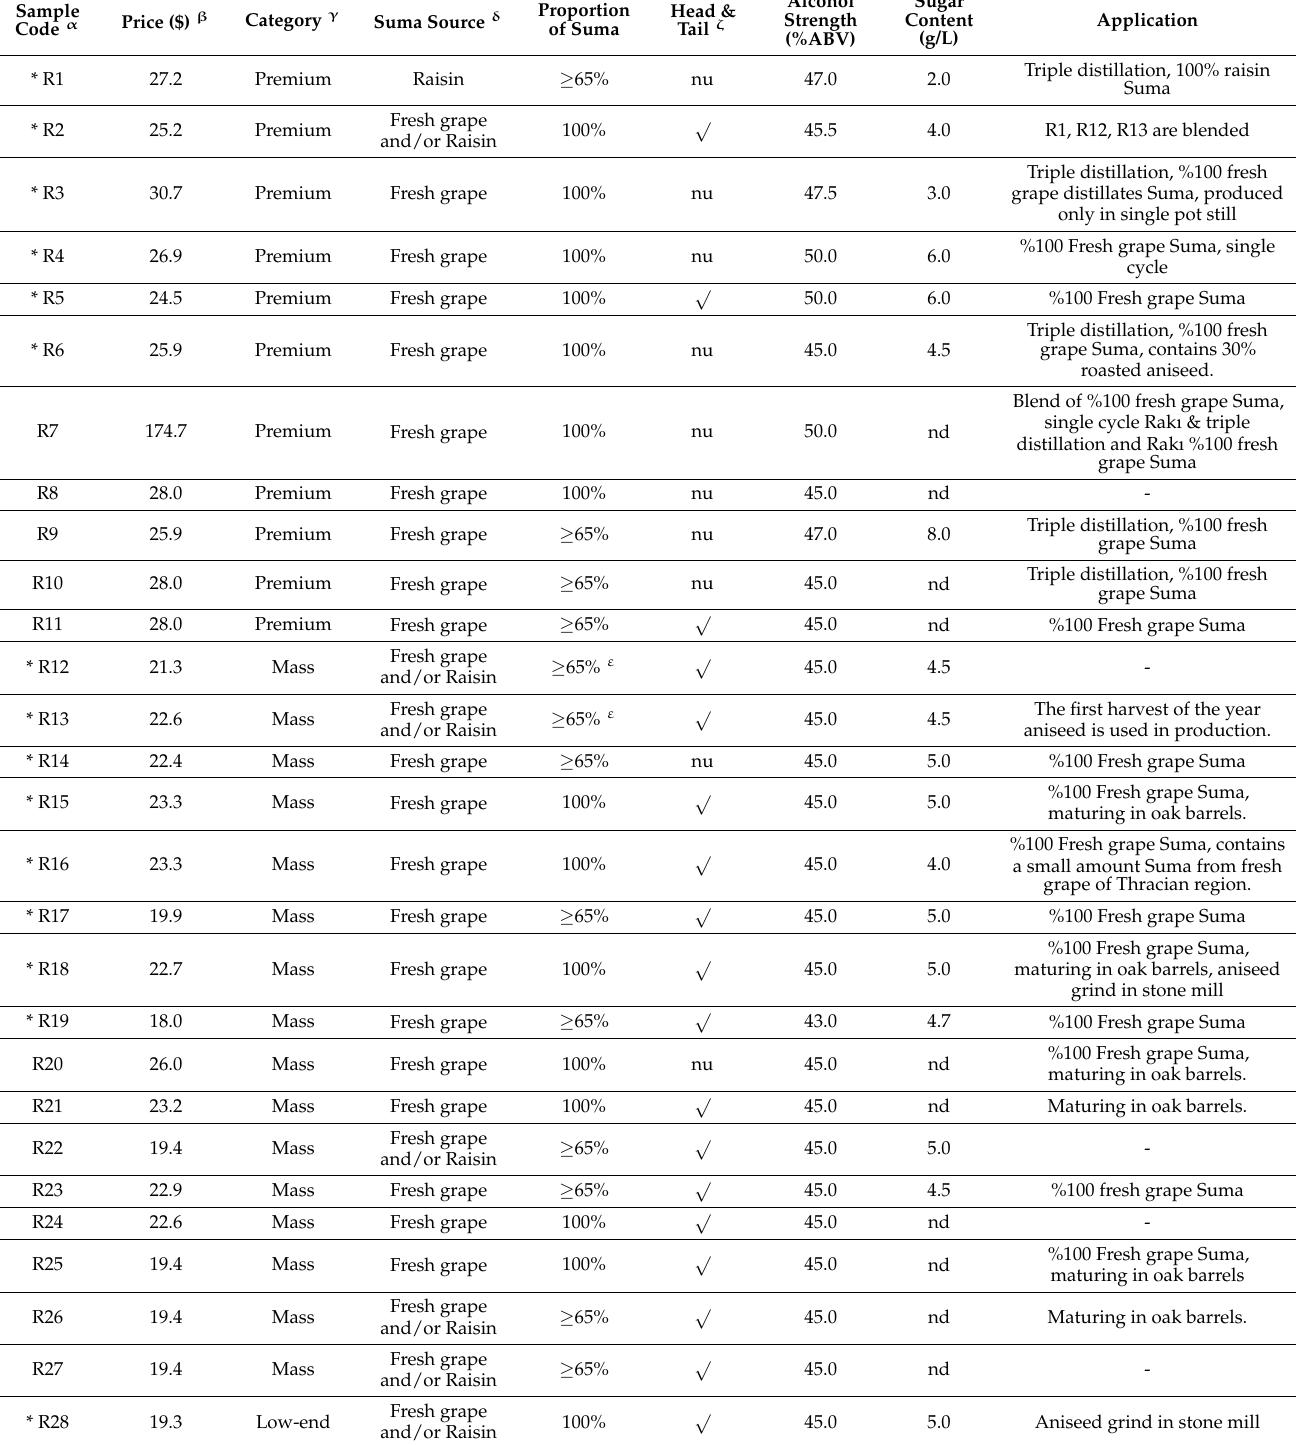
Table 1. Main properties of Rakı samples used during the expert panel